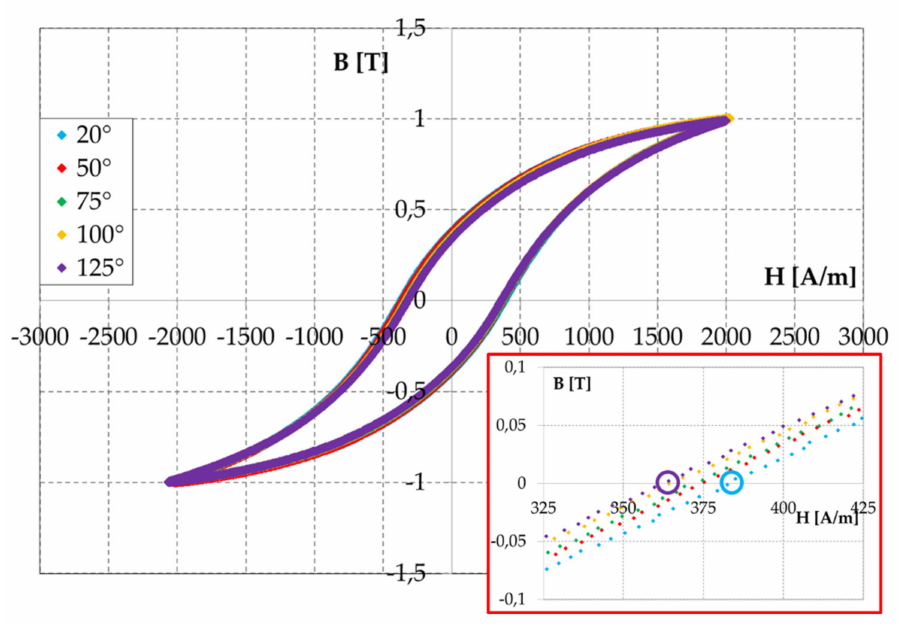
Figure 12. Hysteresis cycles at different temperatures of SMC sample E 0.2-700 for different temperatures.